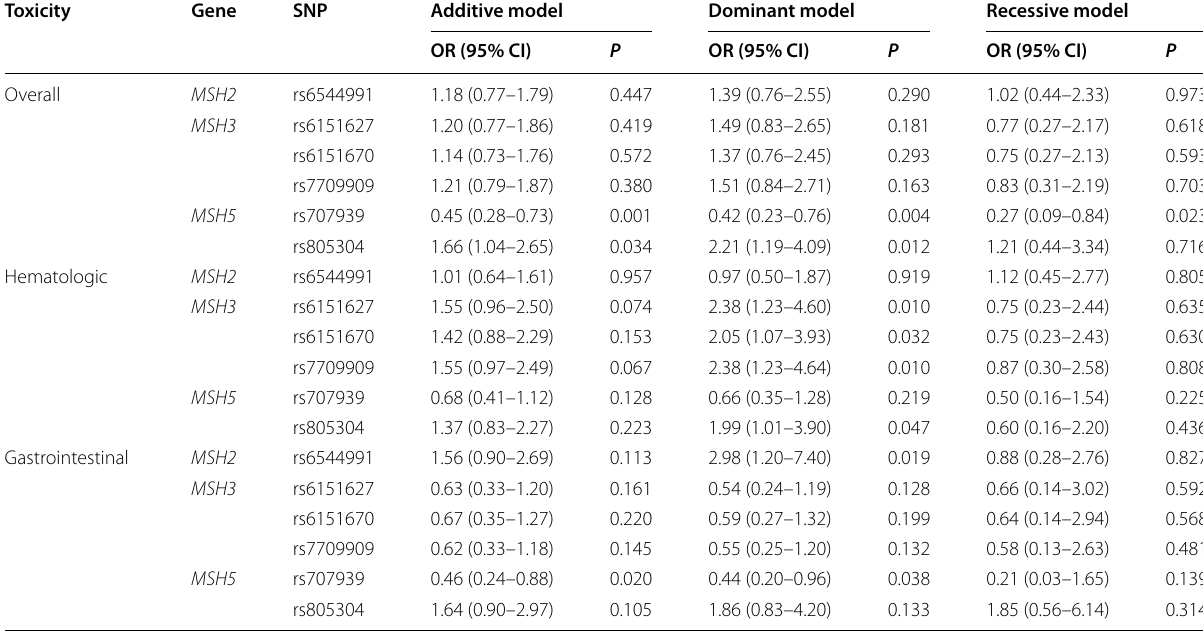
Table 3 Associations between MMR gene polymorphisms and platinum-based chemotherapy toxicity in the 220 NSCLC